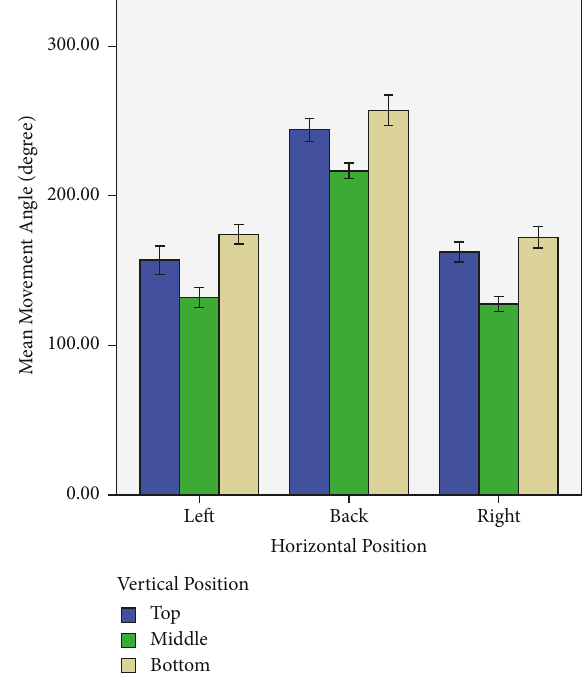
Figure 11: Mean head movement angle for different horizontal positions × Vertical